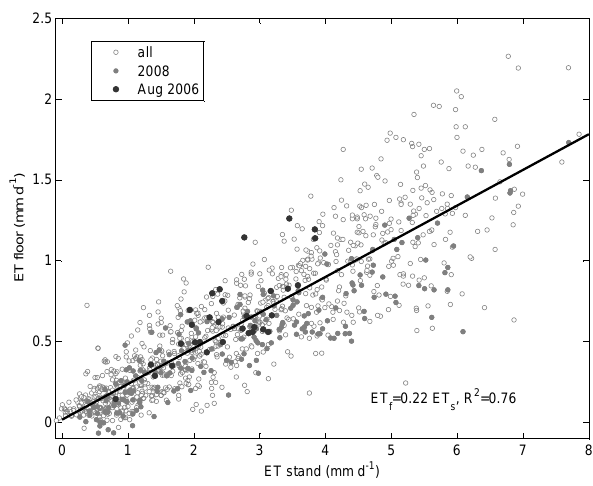
Fig. 9. Daily forest floor evapotranspiration versus whole stand ET for April to October period (2003–2008). In year 2008 ET floor was 18% of stand ET, lower than average 22% shown as linear fit. The drought in August 2006 did not markedly alter the ET